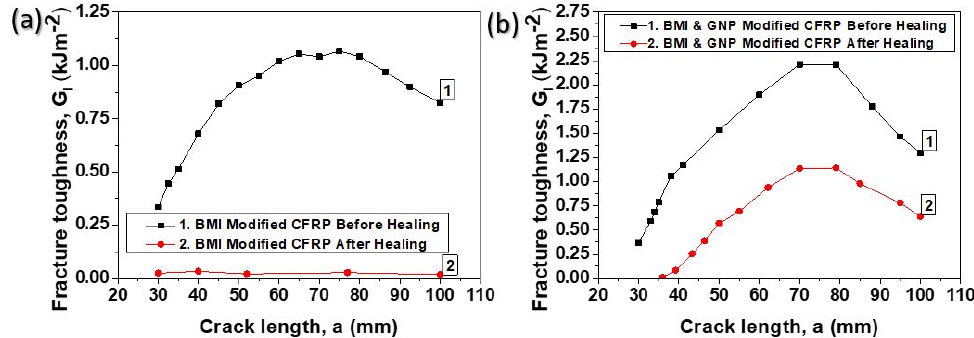
Figure 7. Typical crack opening resistance curves (R-curves) under mode I loading conditions for the modified CFRPs with ( a ) pure BMI and ( b ) BMI and GNPs, before and after the activation of the healing cycle.